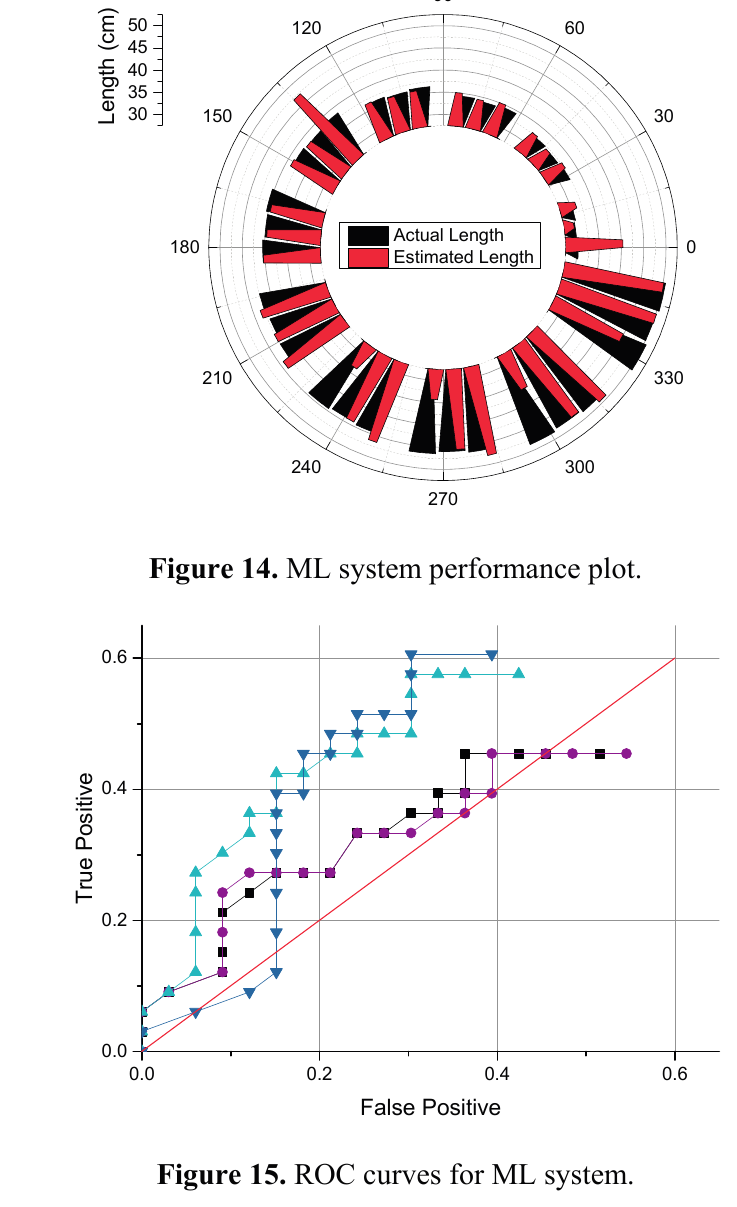
Figure 15. ROC curves for ML